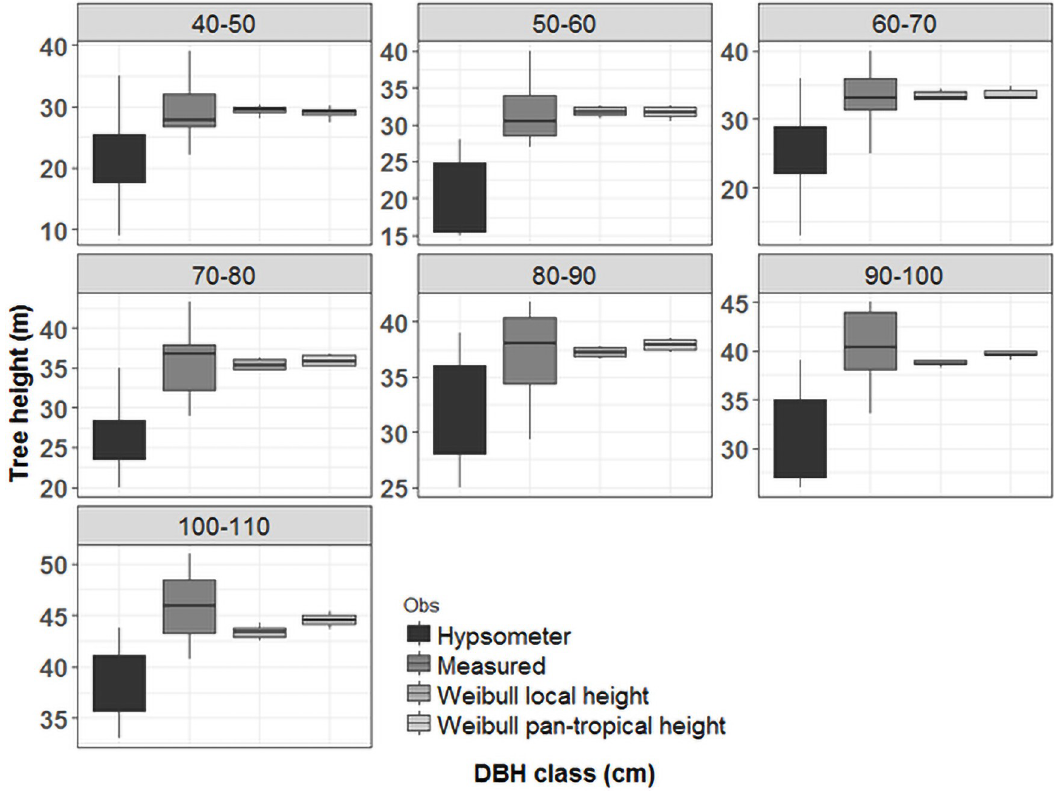
Fig 6. Comparison of height measurements by diameter class between the values generated by the hypsometer—Hypsometer, total length of the felled tree stem—Measured, height generated by the best local model—Weibull local height and height generated by the pan-tropical model—Weibull